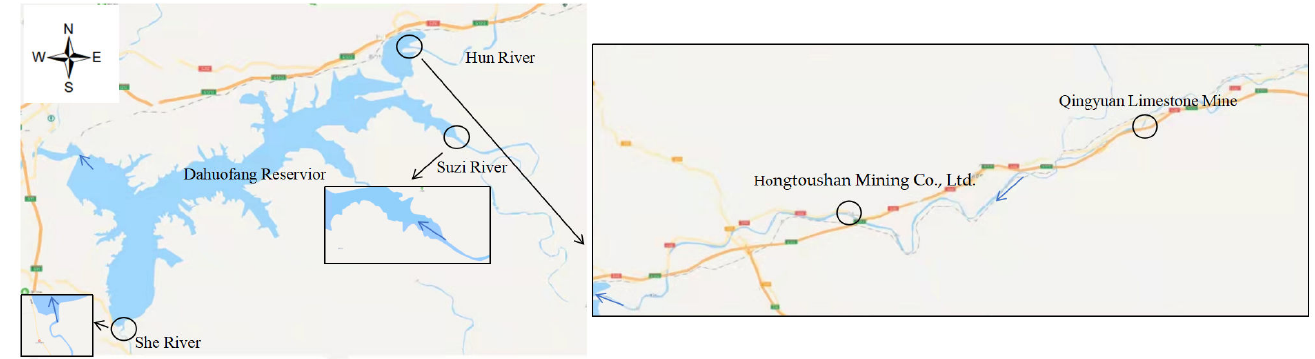
Figure 1. Location map of Dahuofang Reservoir and upstream